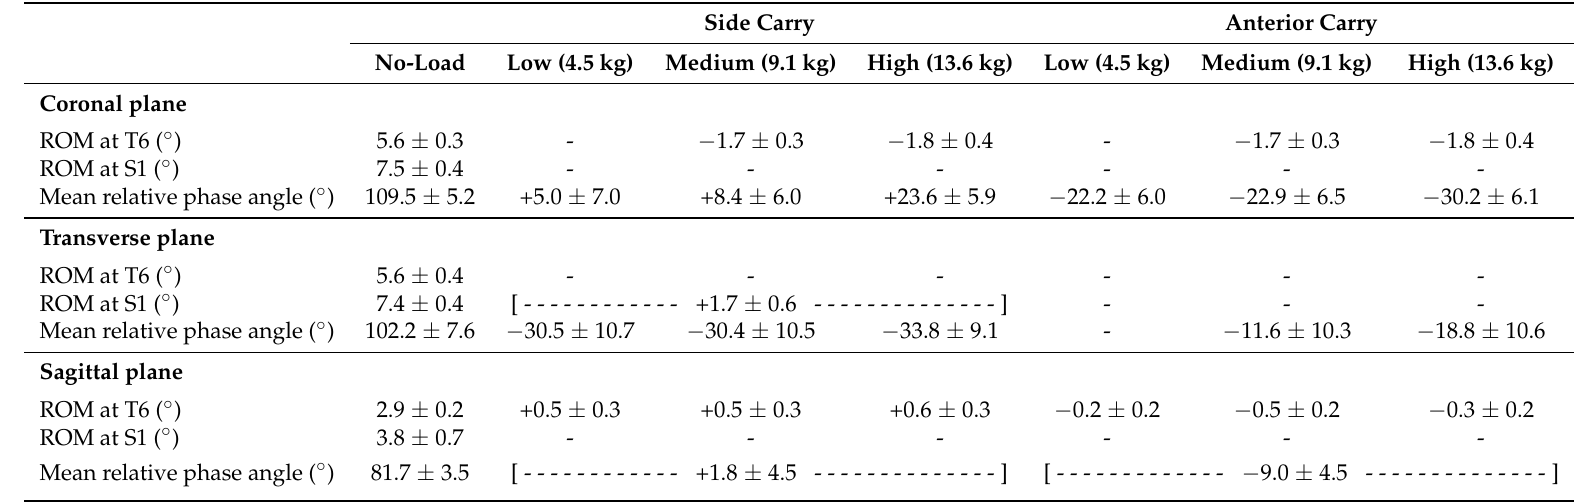
Table 3. Experiment-1 ( n = 9) estimated marginal mean ± SE for the No-load condition, and statistically significant mean differences ± SE relative to the no-load condition by carrying mode and load level, at average values of centered relative speed. Significant mean differences relative to the no-load condition by carrying mode across different load levels are within the square brackets (i.e., [- - mean ± SE -